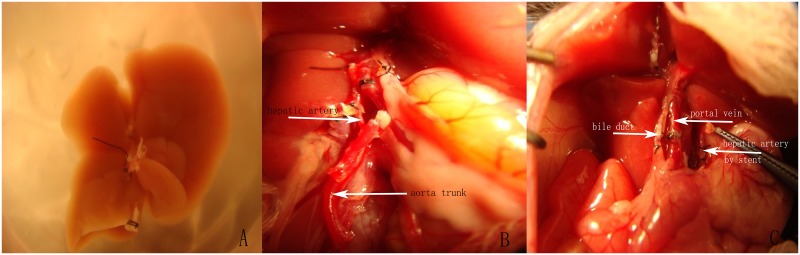
Pictures in the operation.(A) The liver graft was stored in UW solution at 4°C. (B) Reconstruction of the hepatic artery by aortic trunk group (G2). (C) Reconstruction of the hepatic artery by stent group (G3).